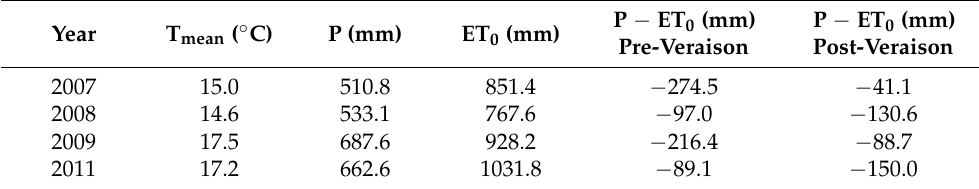
Table 2. Average temperature (T mean ), precipitation (P) and reference evapotranspiration (ET 0 ) for the entire growing cycle, and weather water balance (P − ET 0 ) from bud break to veraison (pre-veraison) and from veraison to harvest (post-veraison). Data are from the meteorological station of Els Hostalets de Pierola (41 ◦ 31 (cid:48) 59 (cid:48)(cid:48) N, 1 ◦ 48 (cid:48) 31 (cid:48)(cid:48) W).